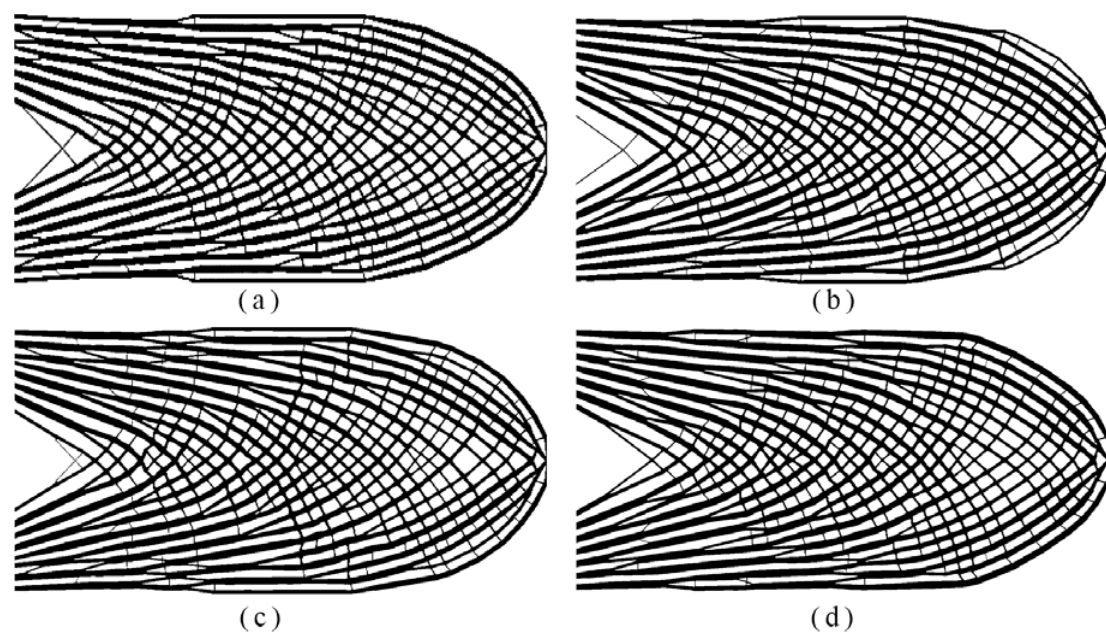
( ) (cid:1) = (cid:0) ρ = max 0.597 ρ 0.597; ; ( b ) 800 e e (cid:1) = (cid:0) ( ) ρ 0.603; ( d ) 1600 × 800: ρ = max 0.603 e ; ( d ) 1600 × 800: c e